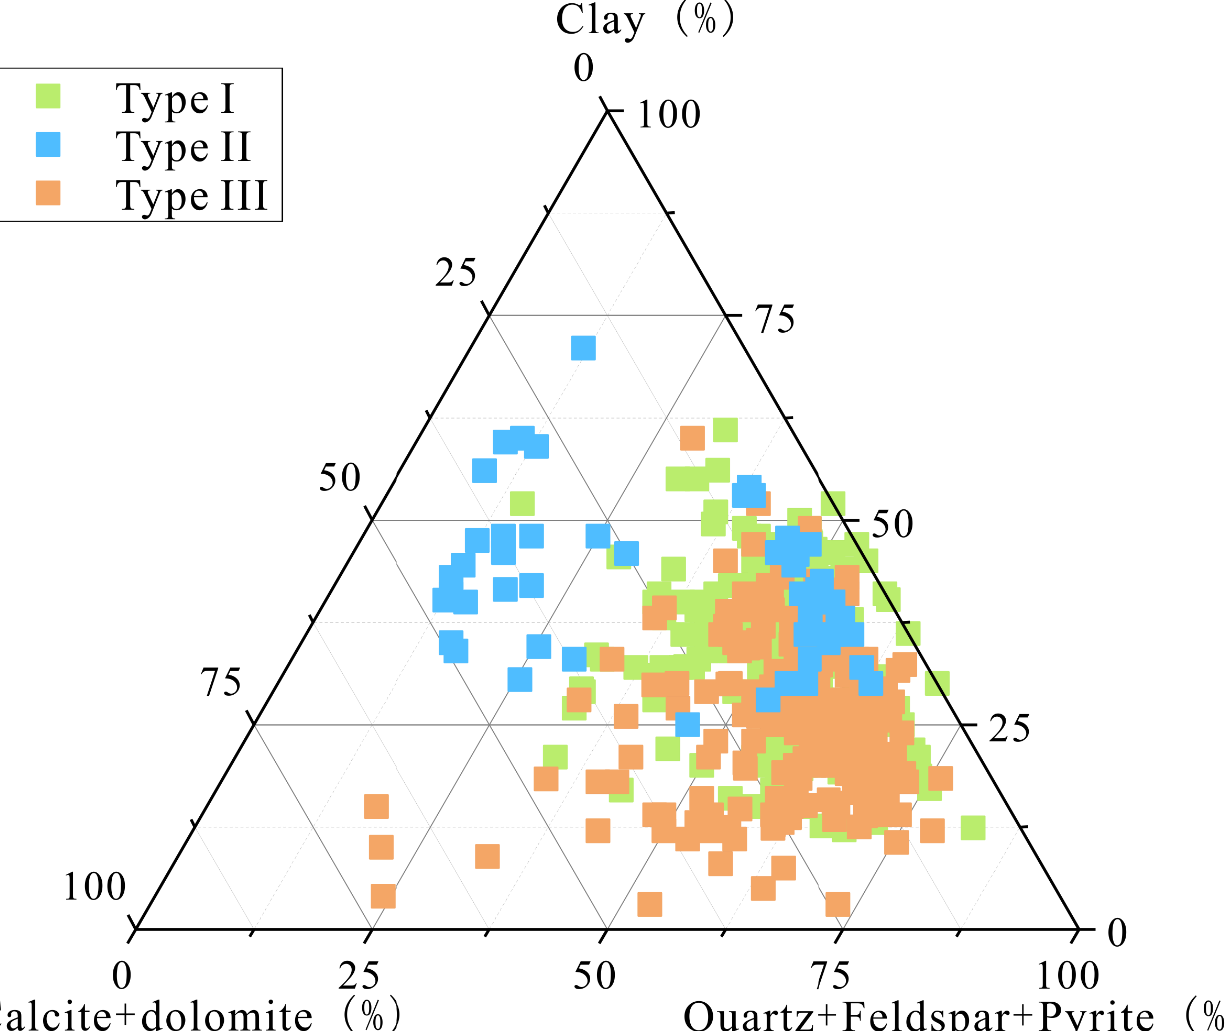
Figure 3. Ternary diagram exhibiting mineral compositions of three low-resistivity shale types in Wufeng-Longmaxi Formation.